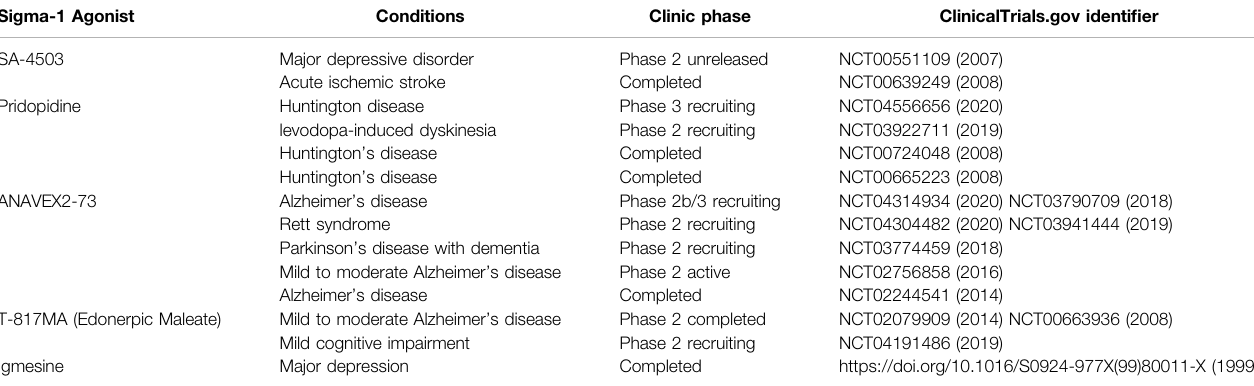
TABLE 1 | Sigma-1 receptor agonists in clinical